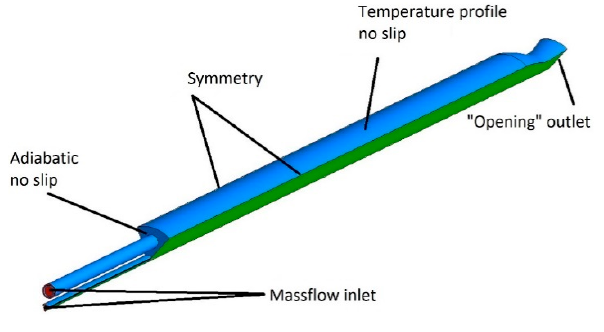
Figure 2. Domain and boundary conditions.